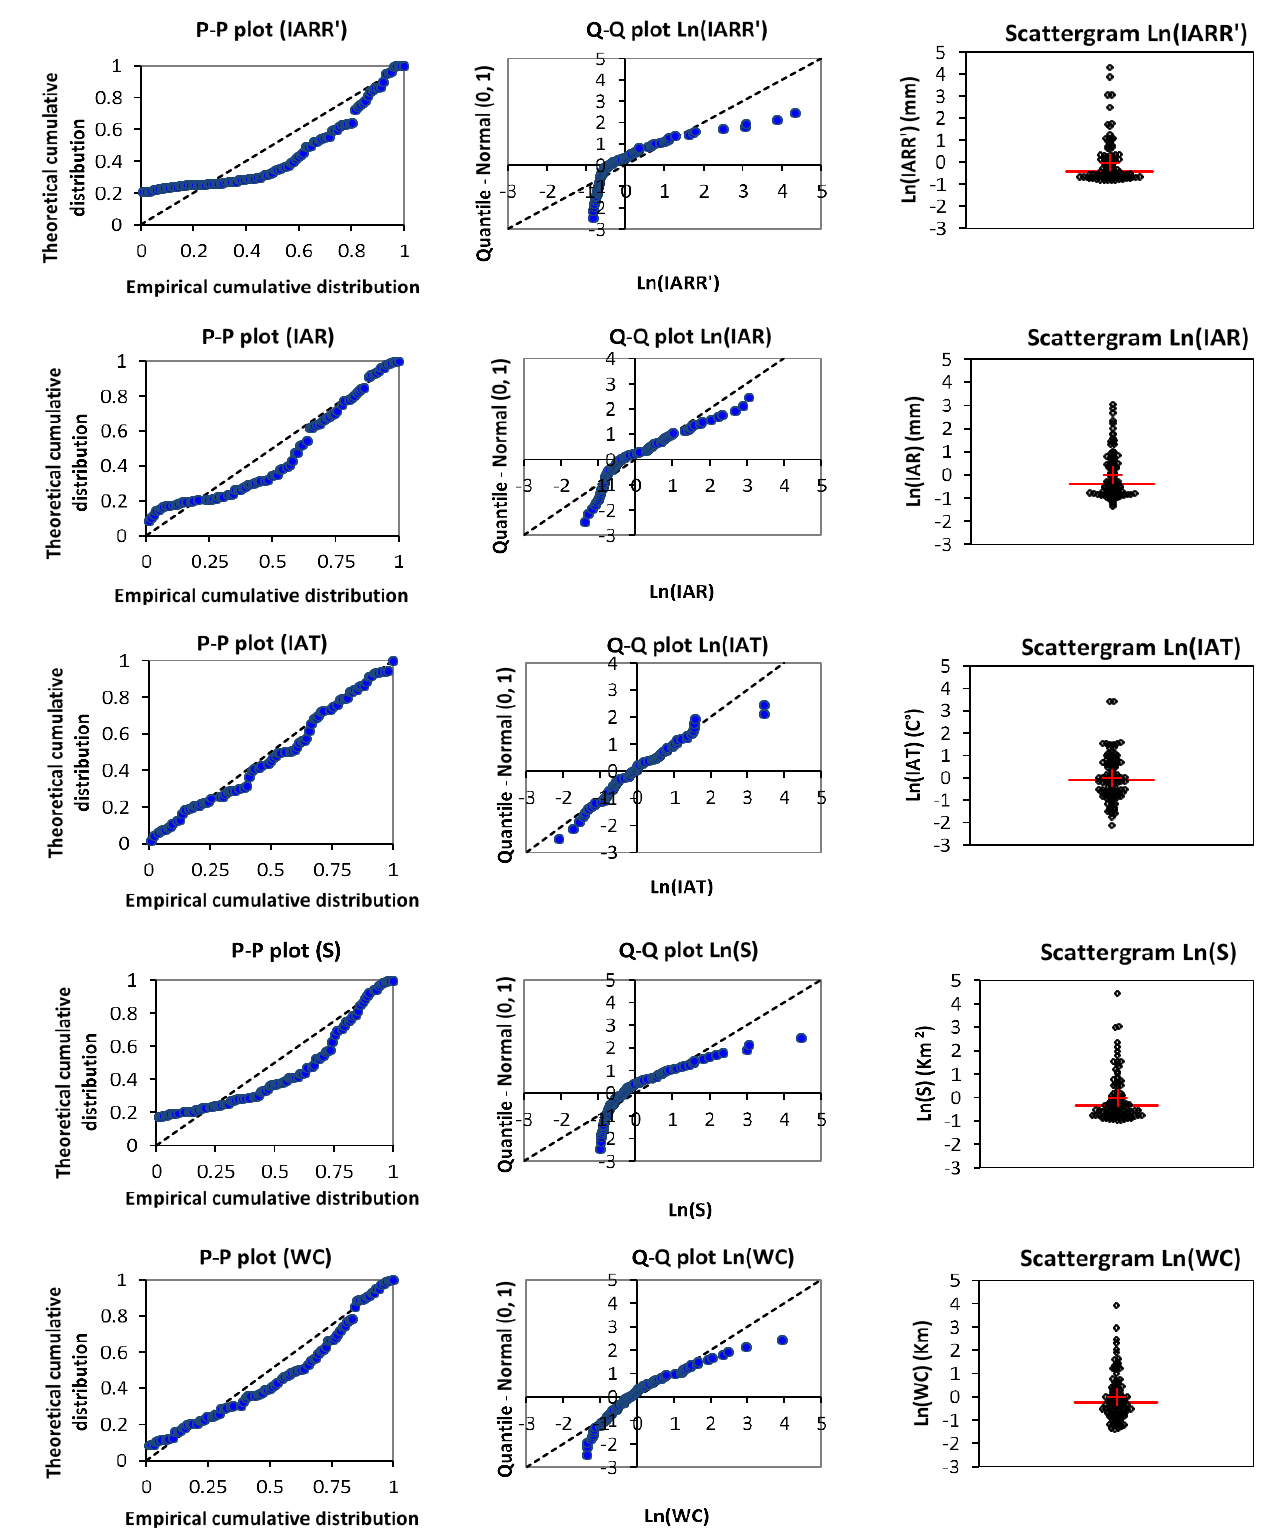
Figure 2. P – P plot, Q – Q plot, and scattergram graph of the dataset series, used in this modeling. Figure 2. P–P plot, Q–Q plot, and scattergram graph of the dataset series, used in this modeling. Inter-annual rainfall-runoff residual (IARR ’ ), inter-annual rainfall (IAR), inter-annual temperature Inter-annual rainfall-runoff residual (IARR’), inter-annual rainfall (IAR), inter-annual temperature (IAT), watershed area (S), and watercourse (WC). (IAT), watershed area (S), and watercourse